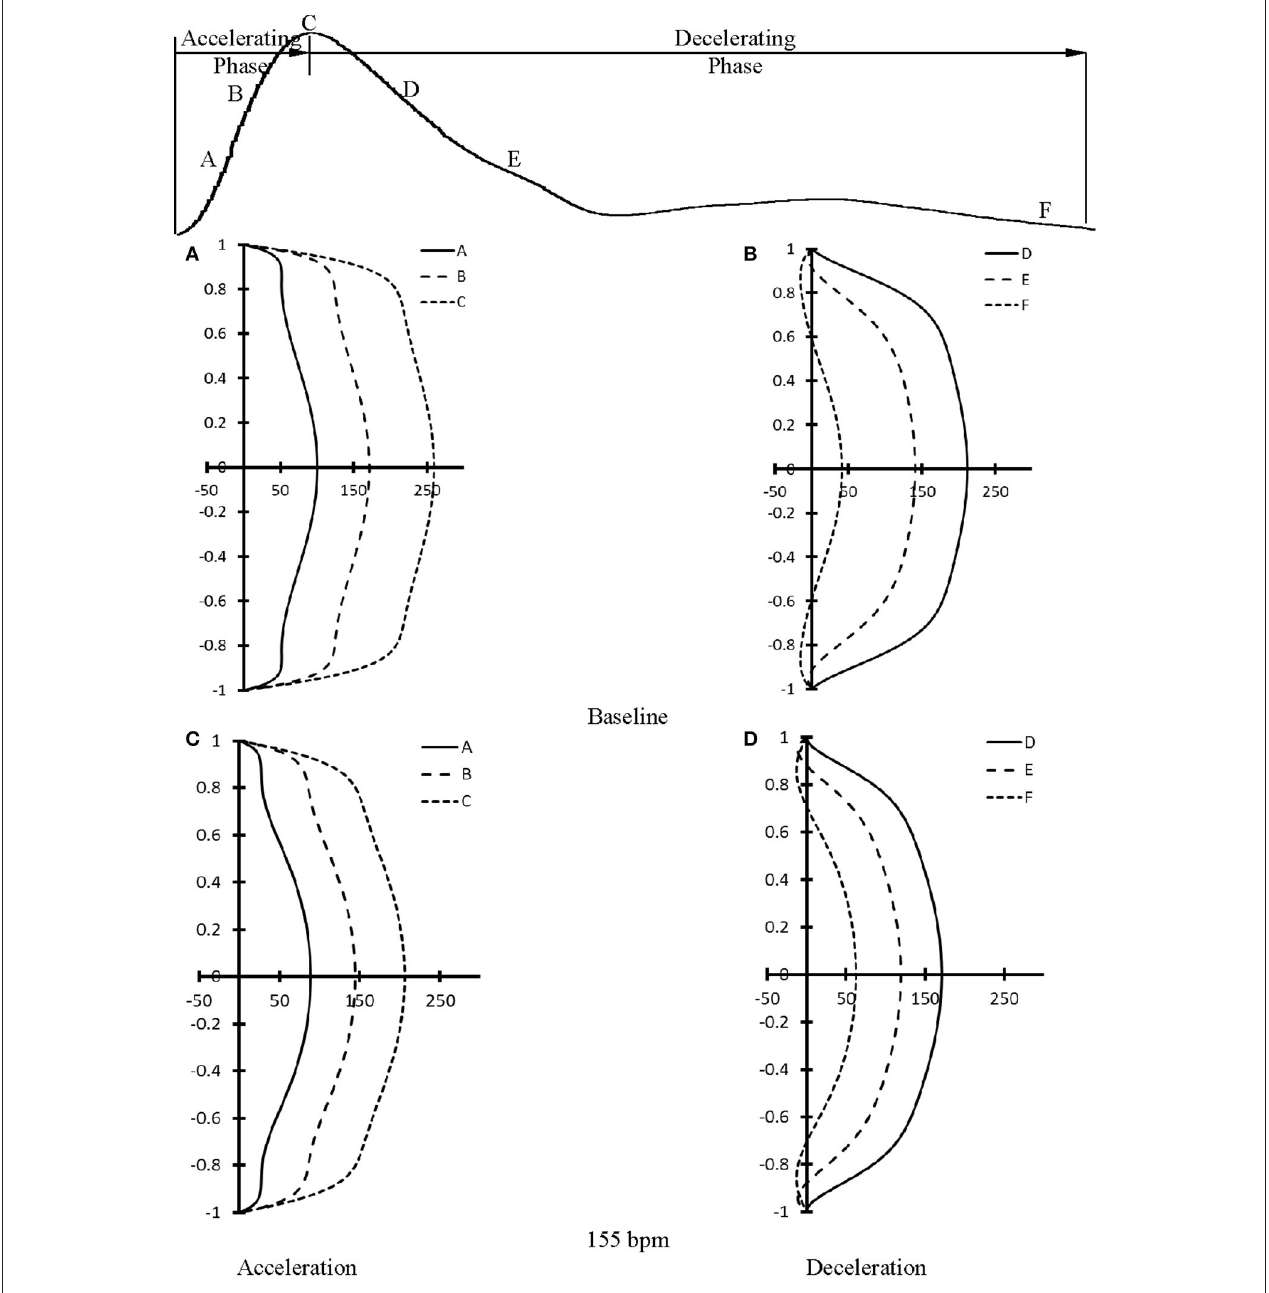
FIGURE 5 | Flow velocity profiles in ascending aorta at various time instances during (A) accelerating and (B) decelerating periods at baseline. (C,D) refer to flow velocity profiles in ascending aorta after the heart rate was paced to 155 bpm in correspondence with (A,B) . (A–F) in (A–D) refer to time instances A–F as shown in the top